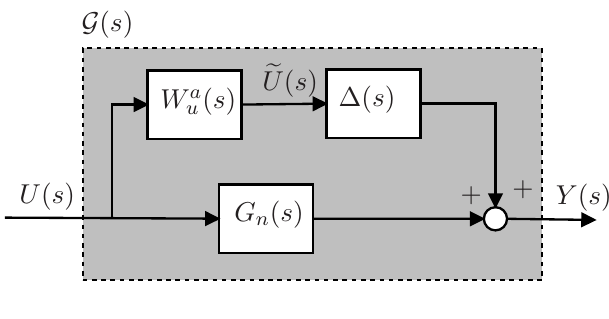
Figure 8. Plant with additive uncertainty.